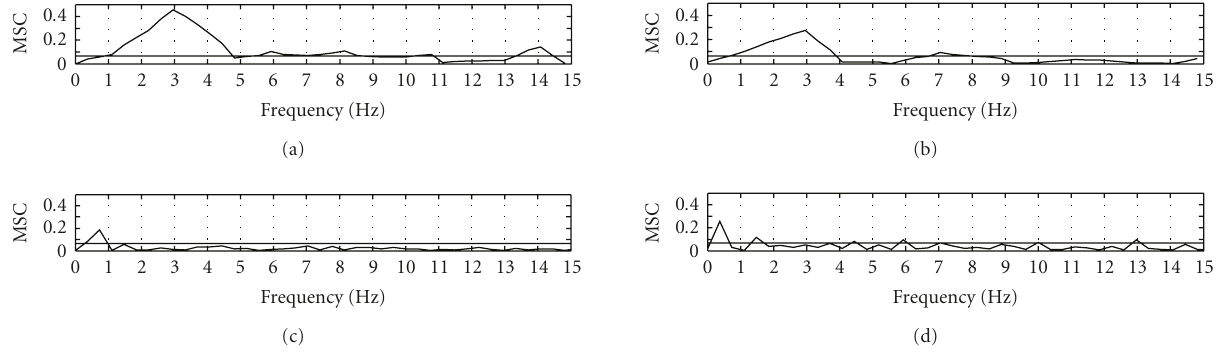
Figure 13: MSC for ERP due to (a) turned o ff LEDs, (b) yellow LED turned on, (c) actual movement, and (d) movement imagination for subject #2. The critical value (MSC critic = 0 . 0658) is represented by the horizontal